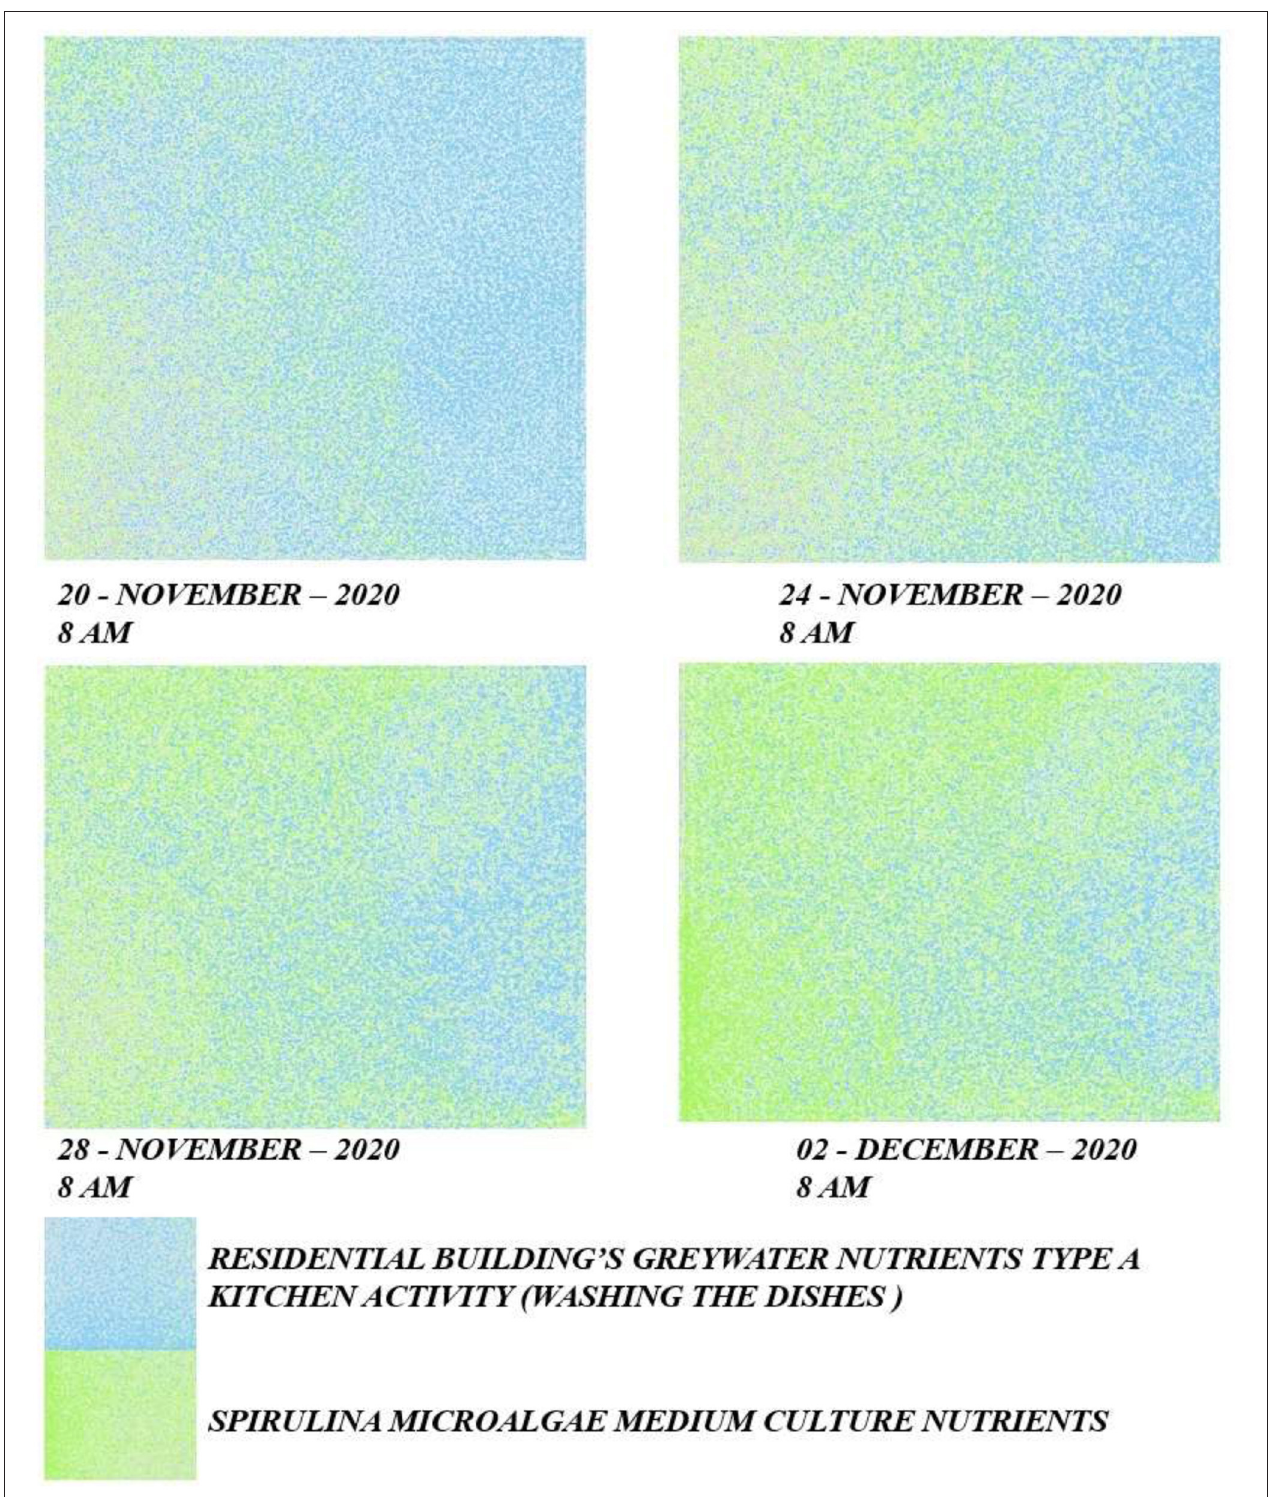
FIGURE 8 | Growth density of microalgae simulation in the hybrid tank-material type A.